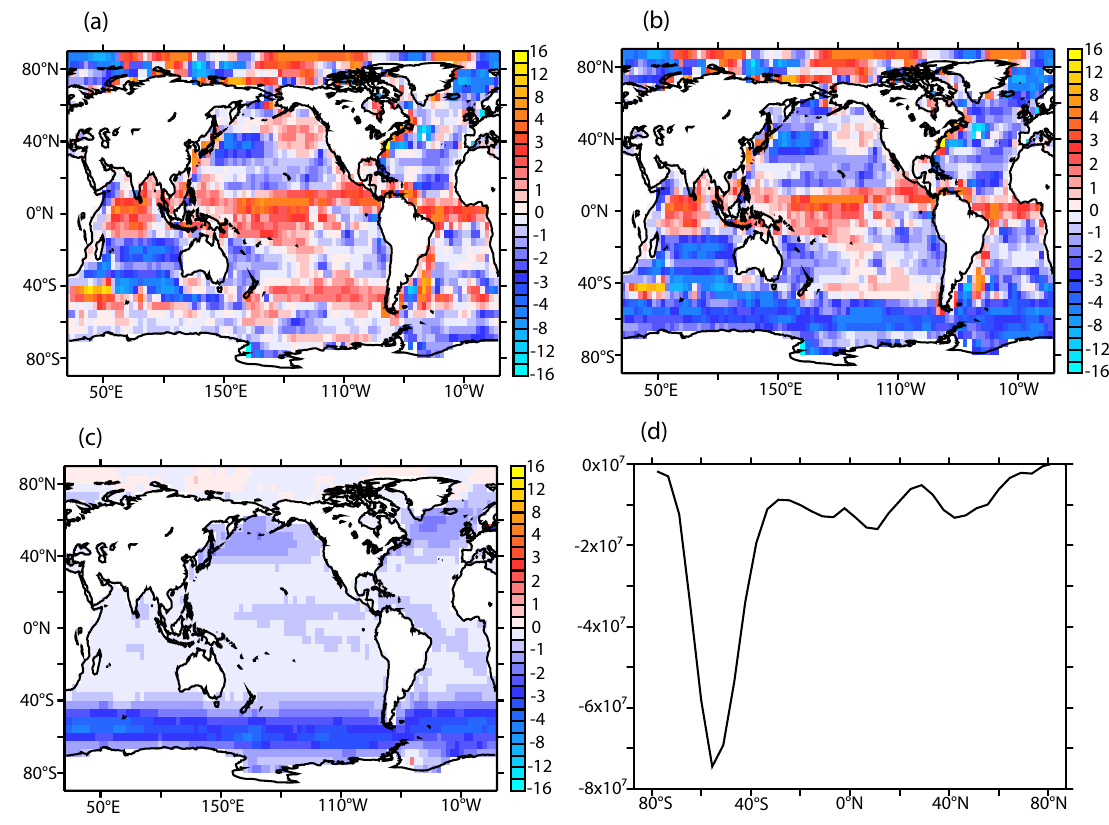
Fig. 2. Surface annual mean sea-air tracer fluxes from the mean state of the MOM3 ocean model. (a) CO 2 flux (molCm − 2 s − 1 ) . (b) 14 CO 2 flux (scaled via multiplication by the late 19th century ratio of 12 CO 2 / 14 CO 2 , or 1 14 C=0, in the atmosphere) (molCm − 2 s − 1 ) . (c) dis- equilibrium flux φ diseq [ 14 CO 2 flux (scaled) minus CO 2 flux] (molCm − 2 s − 1 ) . (d) Zonal integral of the disequilibrium flux [ φ diseq ] (molCm − 1 s − 1 )